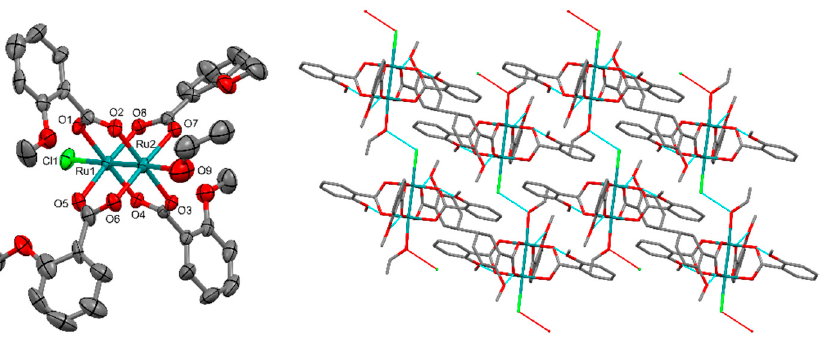
Figure 1. ( Left ) Dimetallic unit of complex 1b . Ellipsoids are drawn at 50% probability level. ( Right ) Packing of compound 1b viewed along crystallography b axis. Hydrogen atoms and atoms involved in disorder are omitted for clarity.